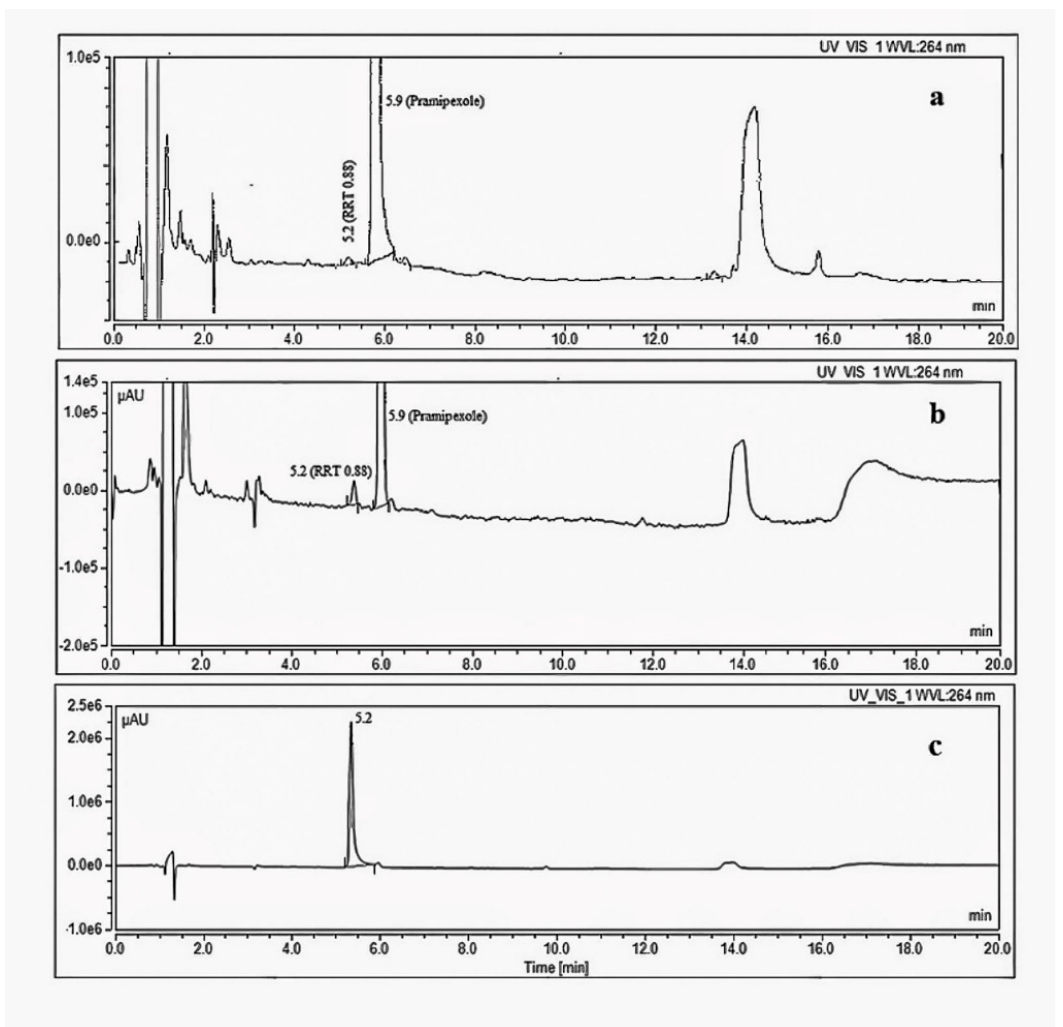
Figure 4. HPLC-UV chromatograms using organic impurity test method in USP monograph of pramipexole ( a ) Initial stability sample, 1.5 mg · mL − 1 ( b ) stability sample stored for 12 months at 30 ◦ C/65%RH, 1.5 mg · mL − 1 ( c ) 0.5 mg/mL solution of the synthesized degradation impurity.